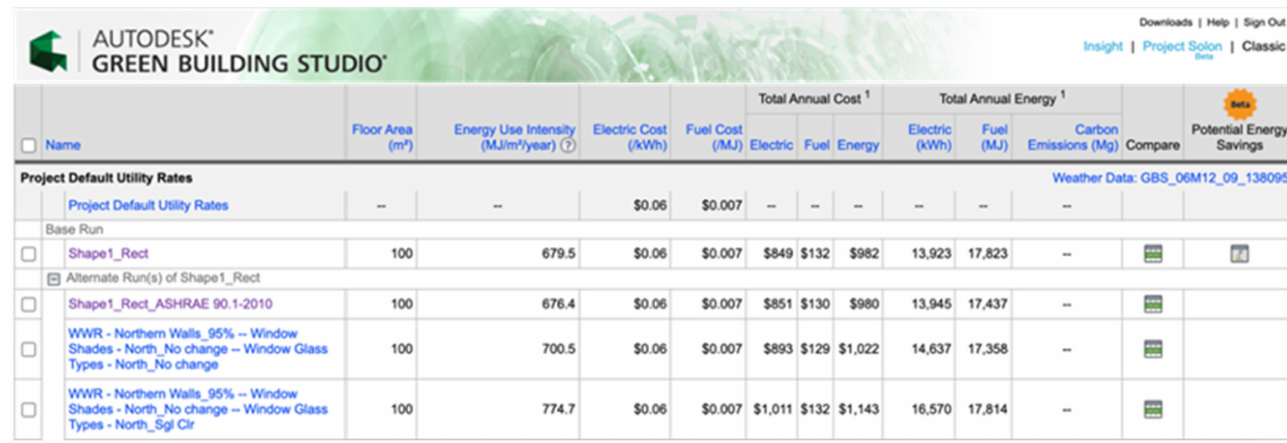
Figure A9. Revit 2022. (2021). Autodesk. Insight. (2021). Autodesk. Green Building Studio. (2021).